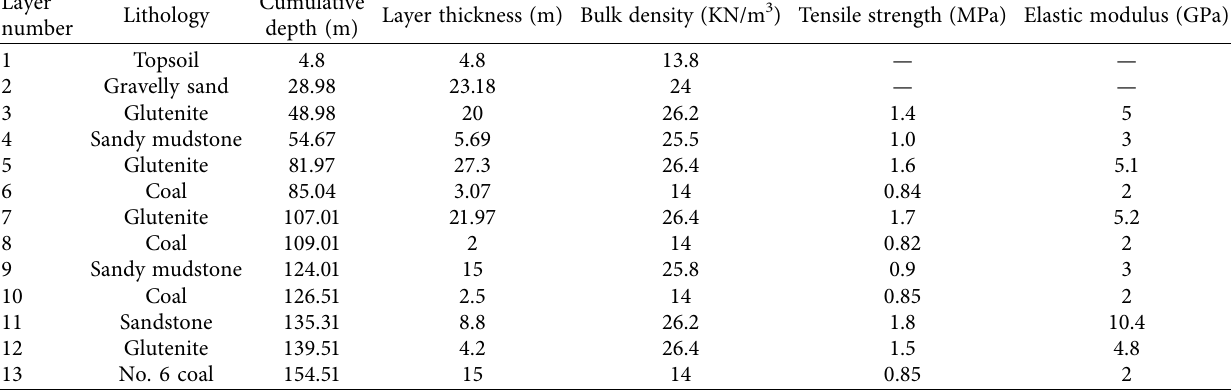
Table 1: Stratification and mechanical parameters of overlying strata in coal seam.